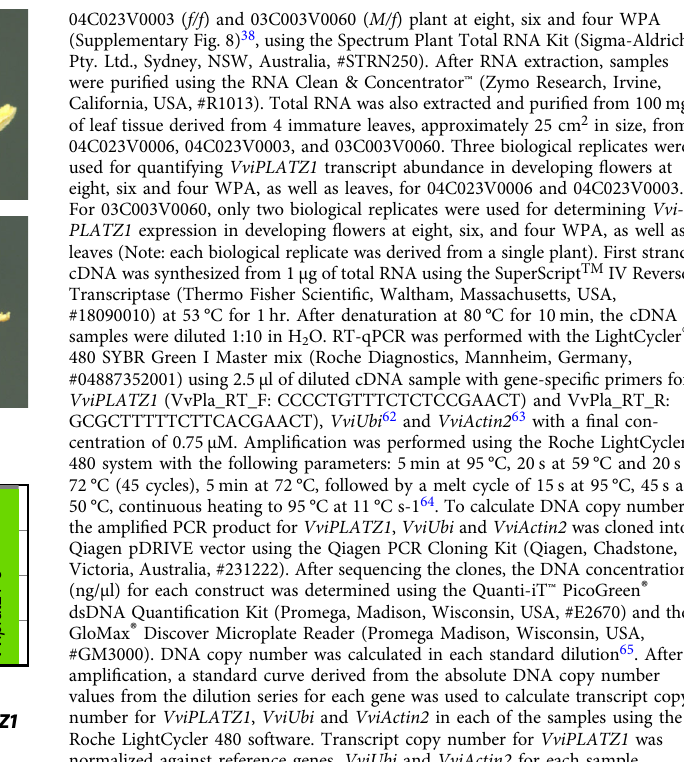
was used to amplify the 33 SNP-targeted regions in each of the DNA samples. After dephosphorylating excess nucleotides in the PCR reactions, a single base extension reaction was performed using an extension primer for each of the 33 SNPs. The extension reaction utilized a single mass-modi fi ed dideoxynucleotide com-